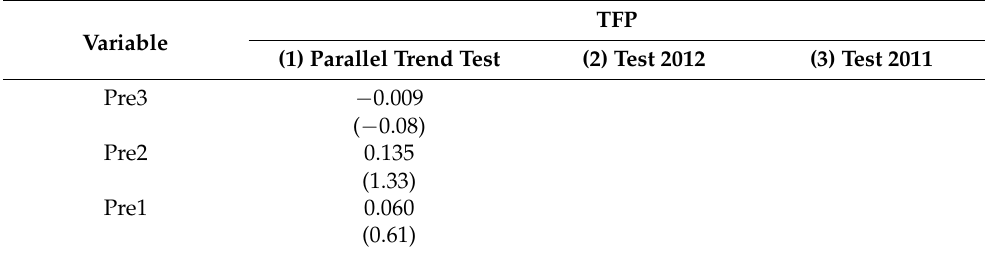
Table 4. Robustness